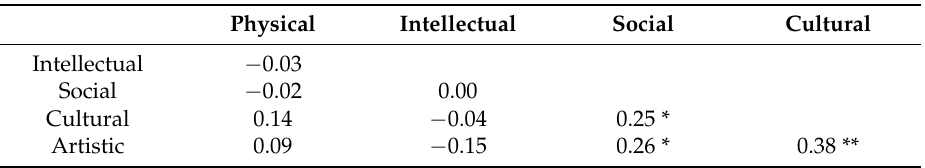
Table 2. Correlations between practices of the different activities. Physical Intellectual Social Cultural Intellectual − 0.03 Social − 0.02 0.00 Cultural 0.14 − 0.04 0.25 * Artistic 0.09 − 0.15 0.26 * 0.38